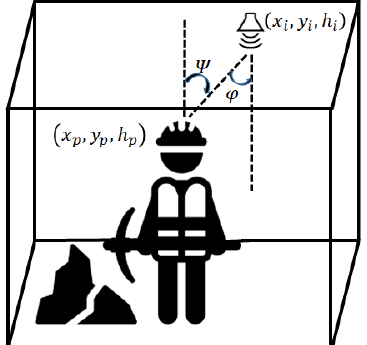
Figure 1. Visible light communication (VLC) channel model used in proposed